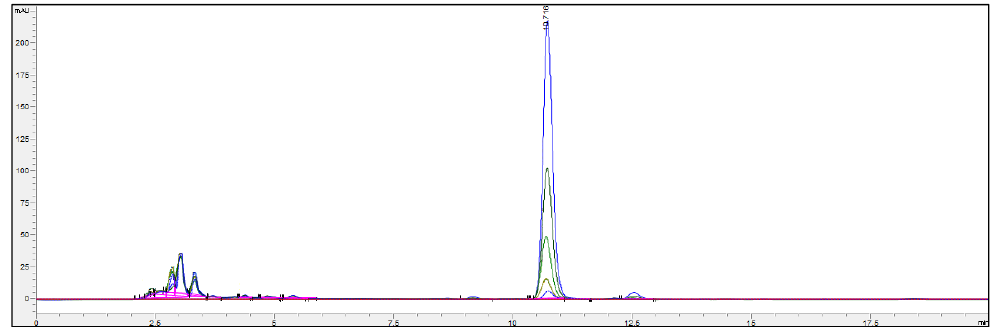
Figure 3. LC ‐ UV ‐ chromatogram of ergosterol obtained with chloroform–methanol extraction from the marine fungal isolate Rhodotorula sphaerocarpa . Five fungal dilutions in artificial seawater are shown (4×, 8×, 16×, 32×, and 64×), and the x ‐ axis shows minutes of the run.